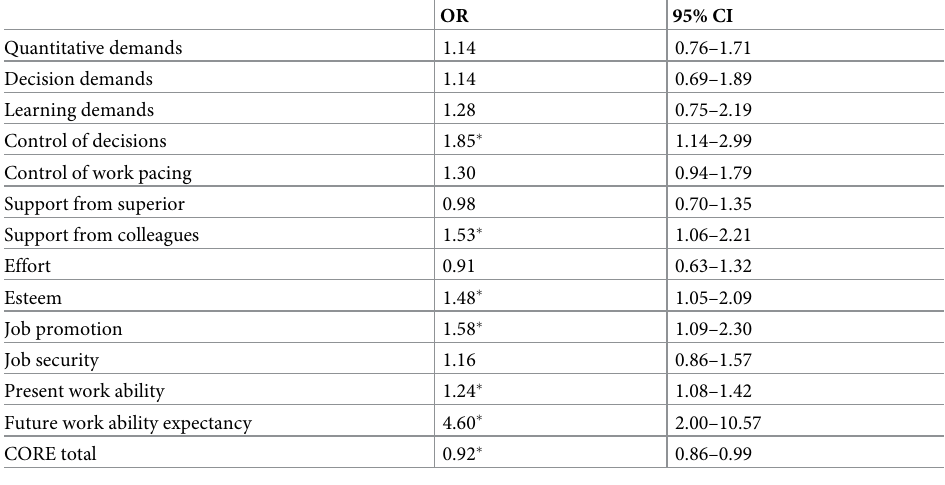
Table 3. Psychosocial work factors, work ability and symptoms at baseline predicting RTW in logistic regression